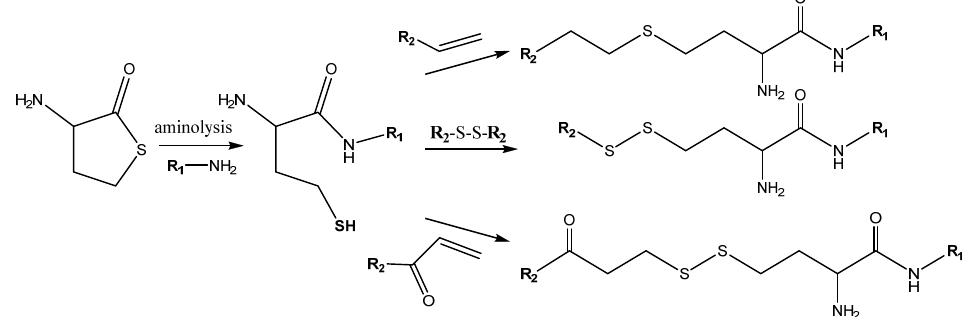
Figure 6. Opening of the HTL ring by aminolysis with subsequent thiol group modification, incorporating R 1 and R 2 residues.